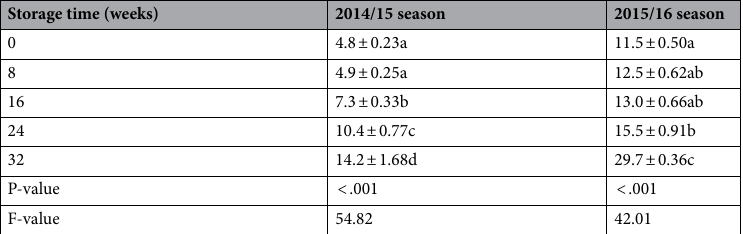
Table 3. Overall time effects on mean percentage grain damage in Mbire district, Zimbabwe during the 2014/15 and 2015/16 sorghum storage seasons (n = 56). Means are compared per column, and those which do not share the same letter are significantly different from one another using Fishers Protected LSD test at 0.05